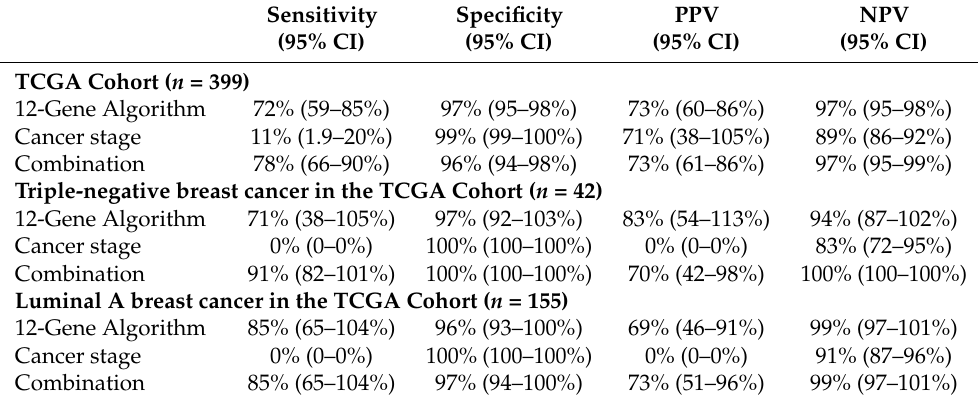
Table 2. Accuracy of the 12-Gene Algorithm and cancer stage for distinguishing treatment responders and non-responders in the TCGA Cohort ( n = 399), triple-negative subgroup ( n = 42), and luminal A subgroup ( n =